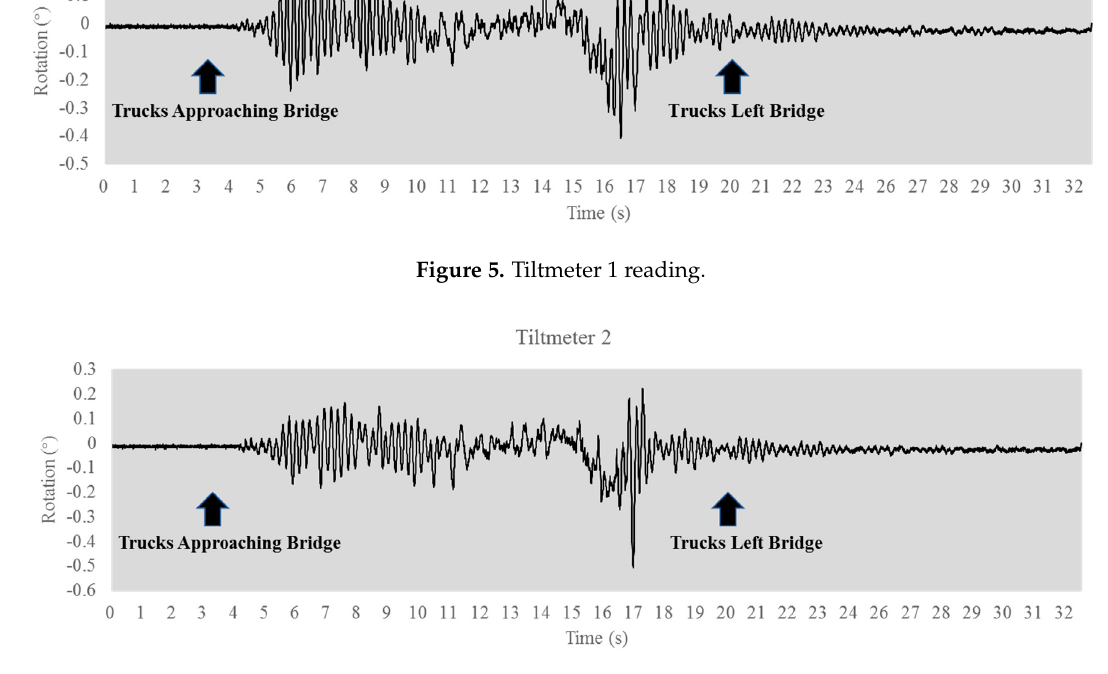
Figure 6. Tiltmeter 2 reading.